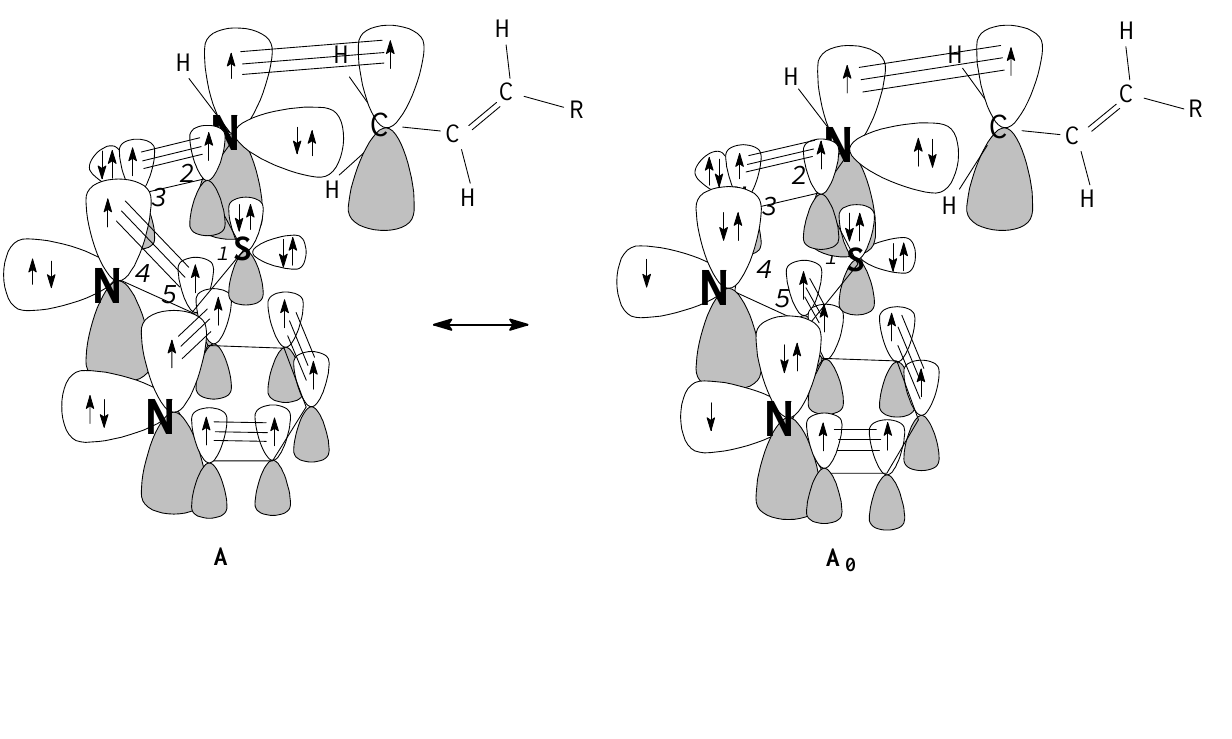
Figure 5 . The resonance structures A A [1,3,4]thiadiazol–2-yl)-amine ( 2